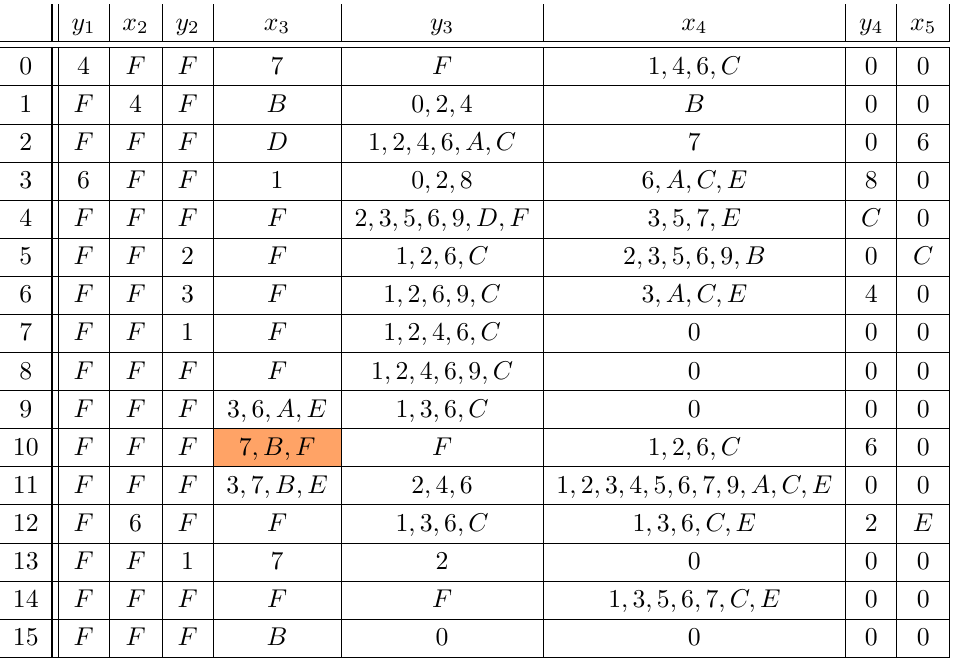
Table 2: Internal state at Step